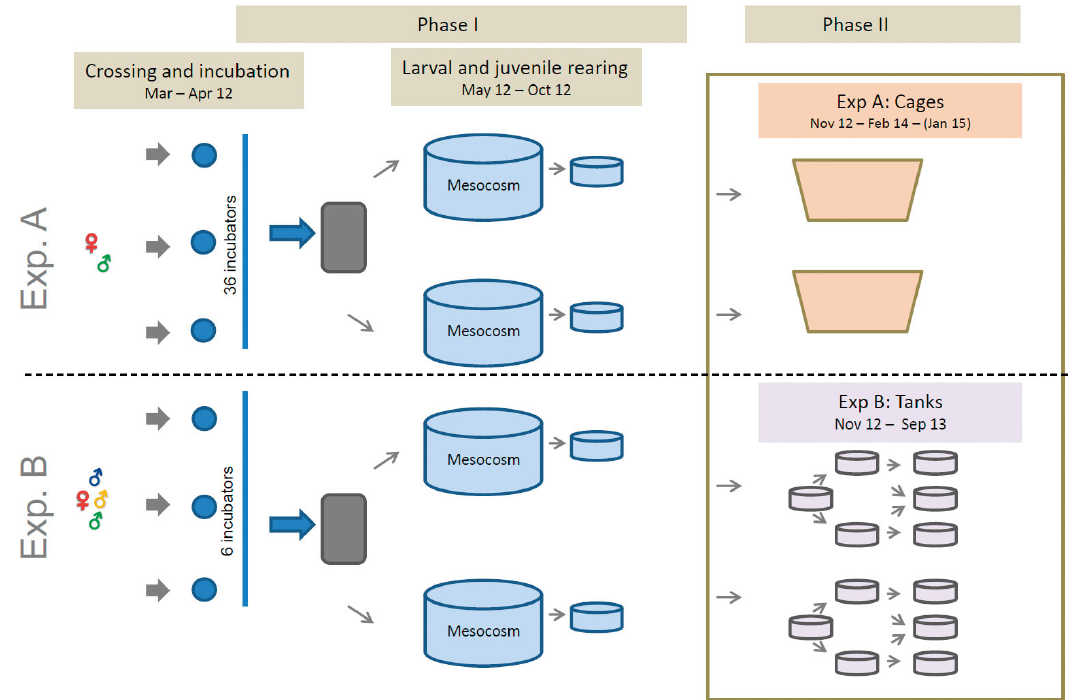
Fig. 1. Overview of the experiments. Egg batches from available female cod were split in 2−4 portions, each fertilized with males of different origin, and incubated. The difference in number of incubators between Expt A and B is mainly due to dif- ferent breeding design between the experiments. In Expt A, each incubator contained 1 cross, while in Expt B, each incuba- tor contained 3 crosses (common female × 3 males; see ‘Materials and methods’ for further details). At the time of hatching, the larvae from the incubators were mixed together in equal proportions (Expts A and B separately) and then divided into 2 replicate mesocosms for larval and juvenile rearing. After harvest from the mesocosms and a period of further growth in holding tanks, approximately 1000 individuals from each of the 4 tanks (mesocosms) were used in a growth experiment, either in cages (Expt A) or tanks (Expt B). The tanks were split on 2 occasions due to the growing